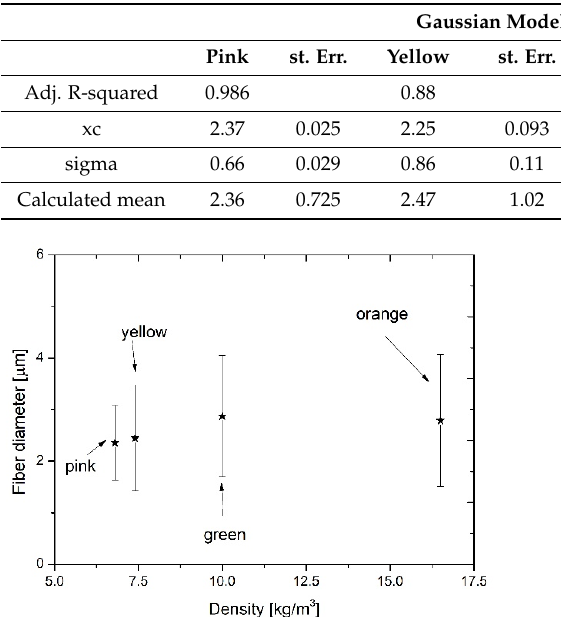
Figure 3. The fiber diameter vs. as ‐ received density.